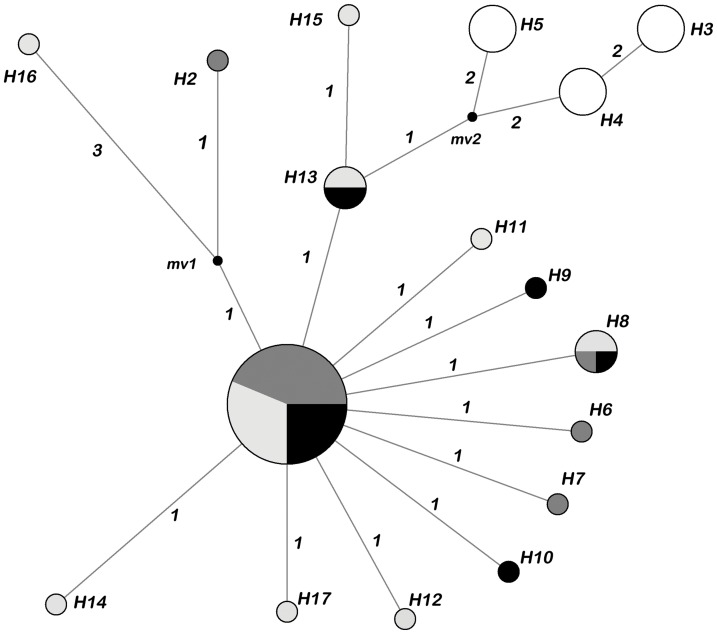
Median-Joining network showing the relationships among Furnestinia echeneis haplotypes defined by COI sequences variation.Numbers along each branch designate the number of base differences among haplotypes. Circle sizes are proportional to the frequency of each haplotype. mv1–mv2 are median vectors and represent the possible extent of unsampled sequences or extinct ancestral sequences. In black, grey, white-grey and white background, F. echeneis haplotypes sampled from Adriatic wild sea bream, Adriatic cage sea bream adults, Adriatic cage sea bream fingerlings and western Mediterranean wild sea bream (Gulf of Lion), respectively.